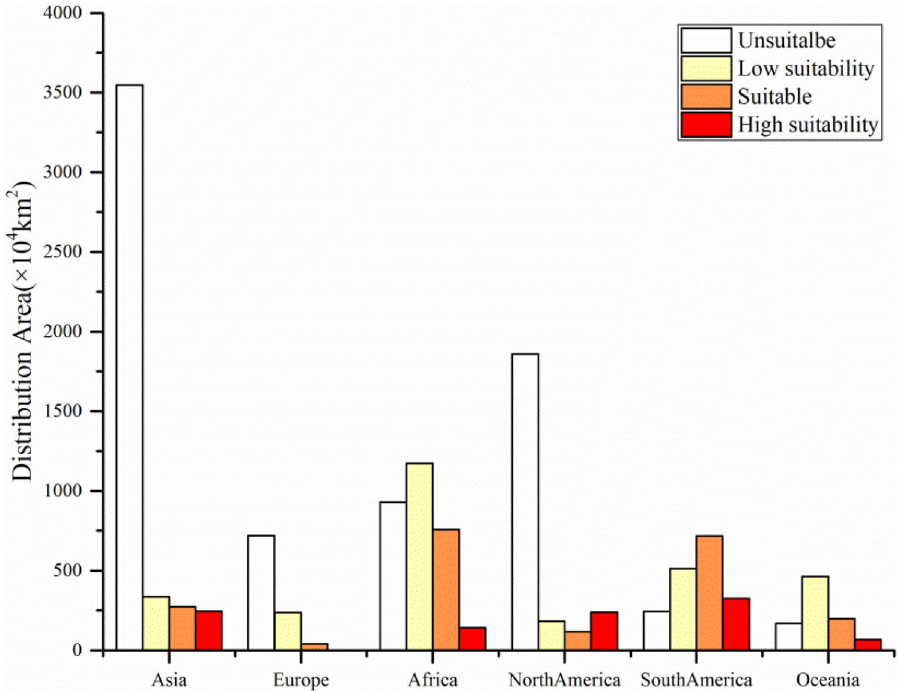
Figure 2. Distribution area of Sapindus habitats on six continents under the current